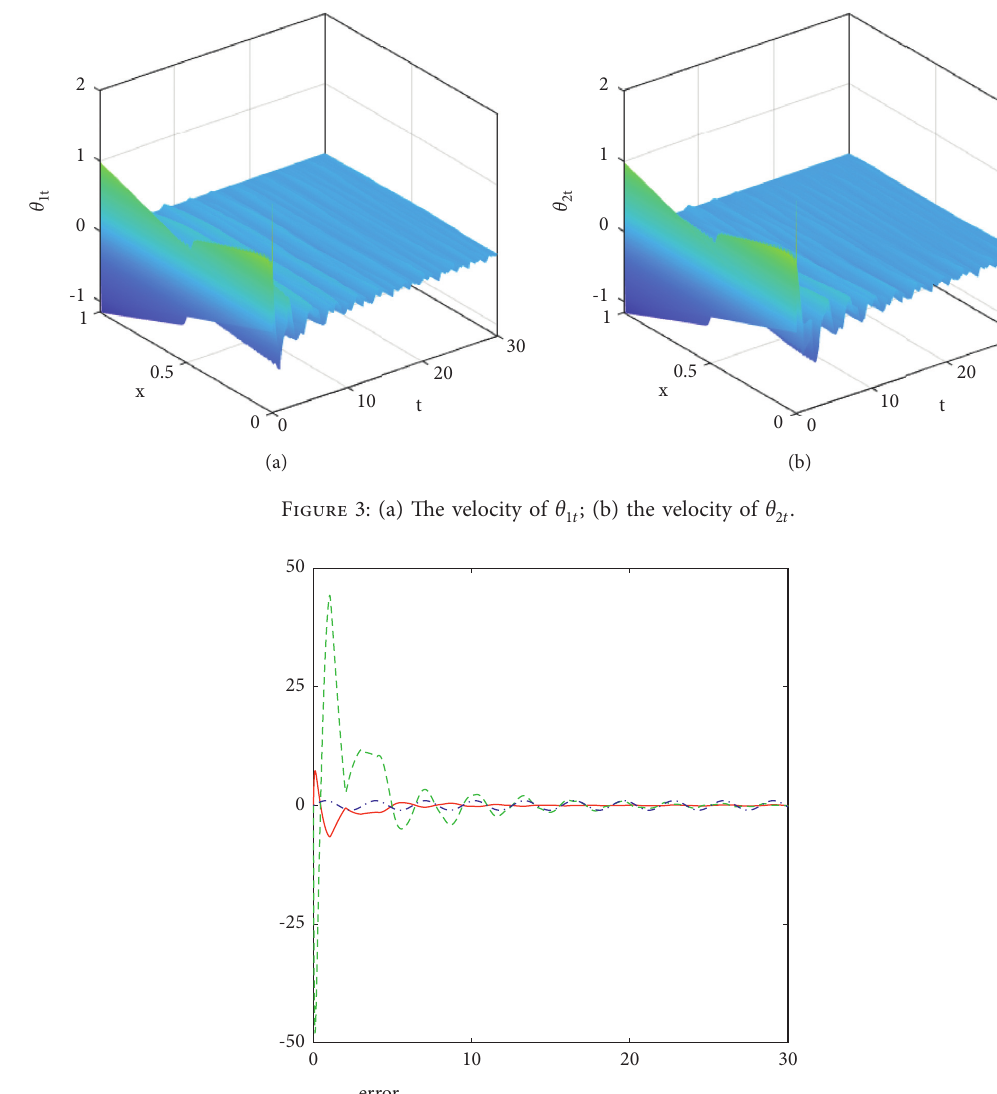
; (b) the displacement of θ 1